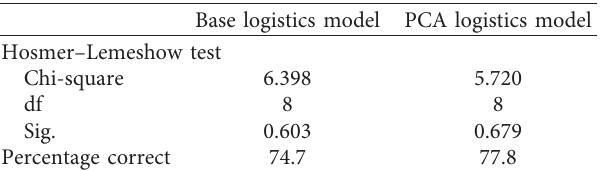
Table 9: Goodness-of-fit statistics for logistics regression.